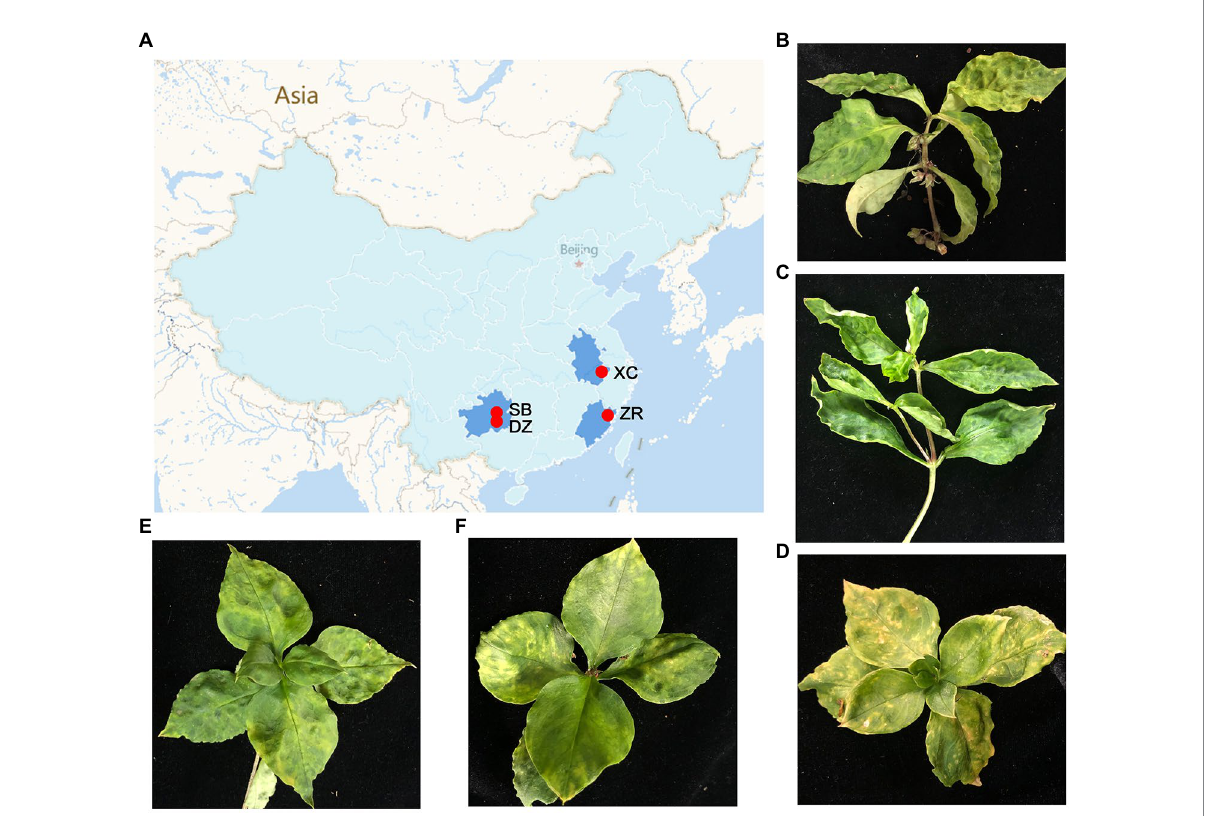
FIGURE 1 Geographical regions of the Pseudostellaria heterophylla samples collected in China and the leaf symptoms of P. heterophylla viral diseases. (A) A map that displays the four different geographical regions in China in which the P. heterophylla samples were collected. (B–F) Symptoms displayed on P. heterophylla leaves collected from SB, XC, ZR-HB, DZ, and ZR-GX, respectively. DZ and SB represent Danzhai County (DZ) and Shibing County (SB) in Guizhou Province, respectively. ZR-HB and ZR-GX represent Huangbai village (ZR-HB) and Gongxi village (ZR-GX) in Zherong County in Fujian Province, respectively. XC represents Xuancheng city (XC) in Anhui